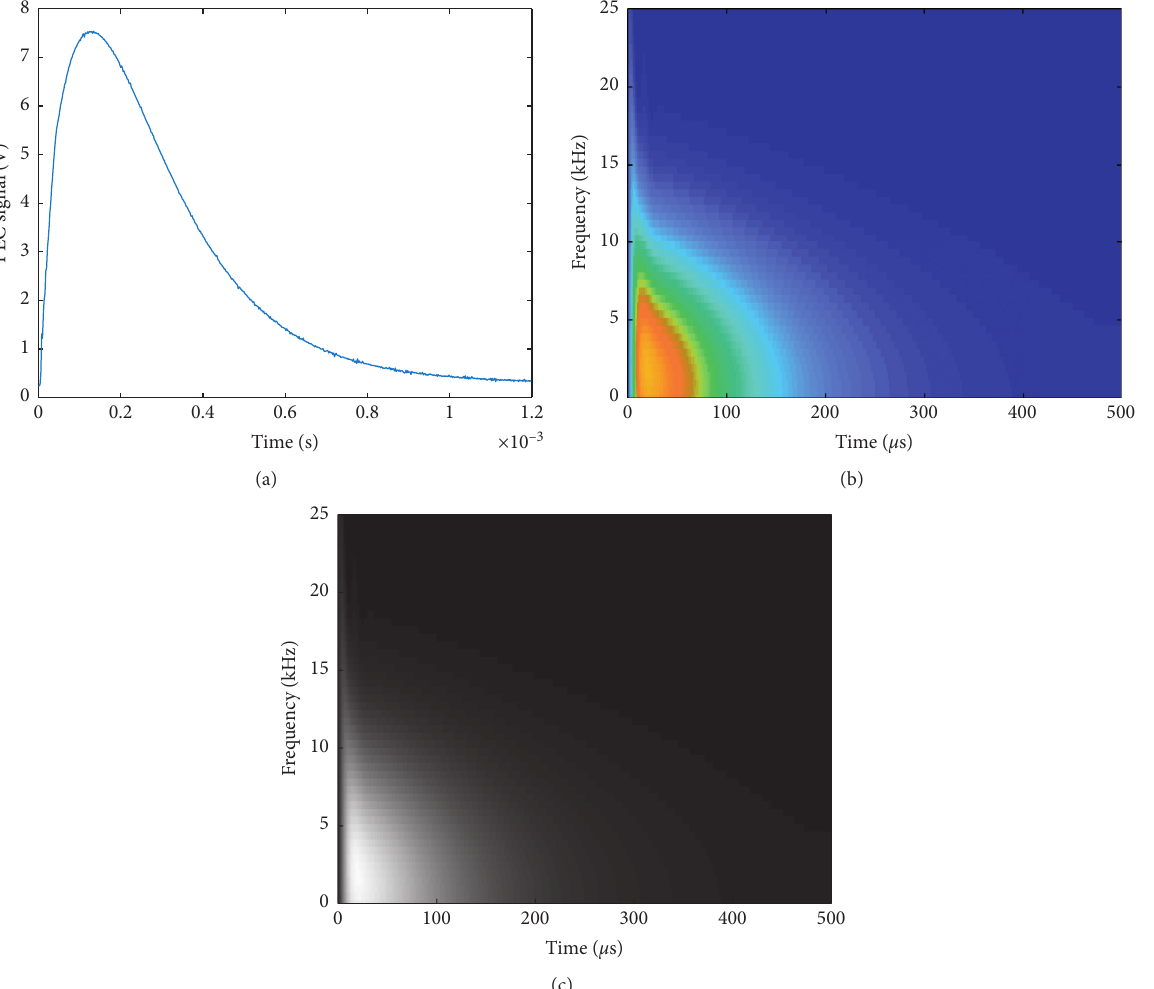
Figure 8: TFR obtained using the PSWVD method: (a) PEC signal; (b) TFR; (c) gray